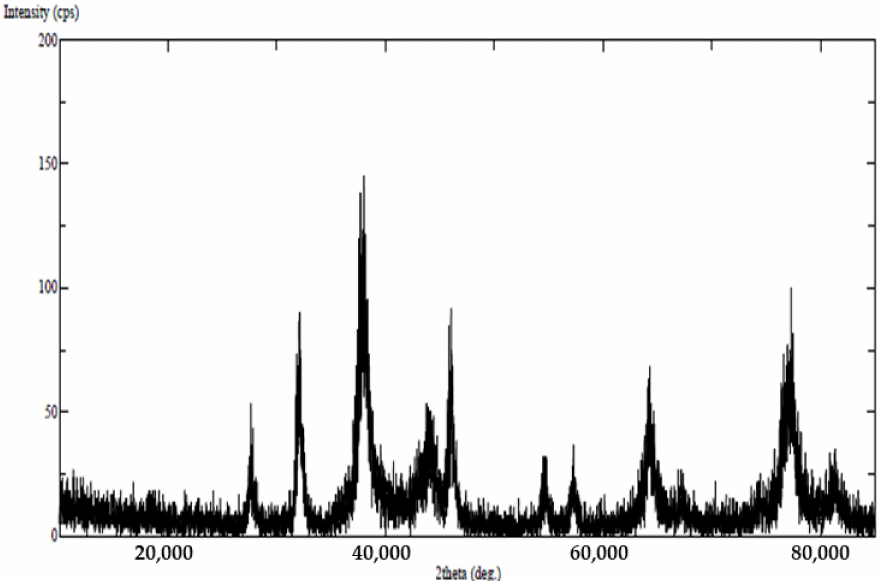
Figure 3. XRD spectrum pattern of biosynthesized AgNPs from the aqueous extract of S. molle . The diffraction planes at (111), (200), (220), and (311) reveal the cubic crystalline nature of the